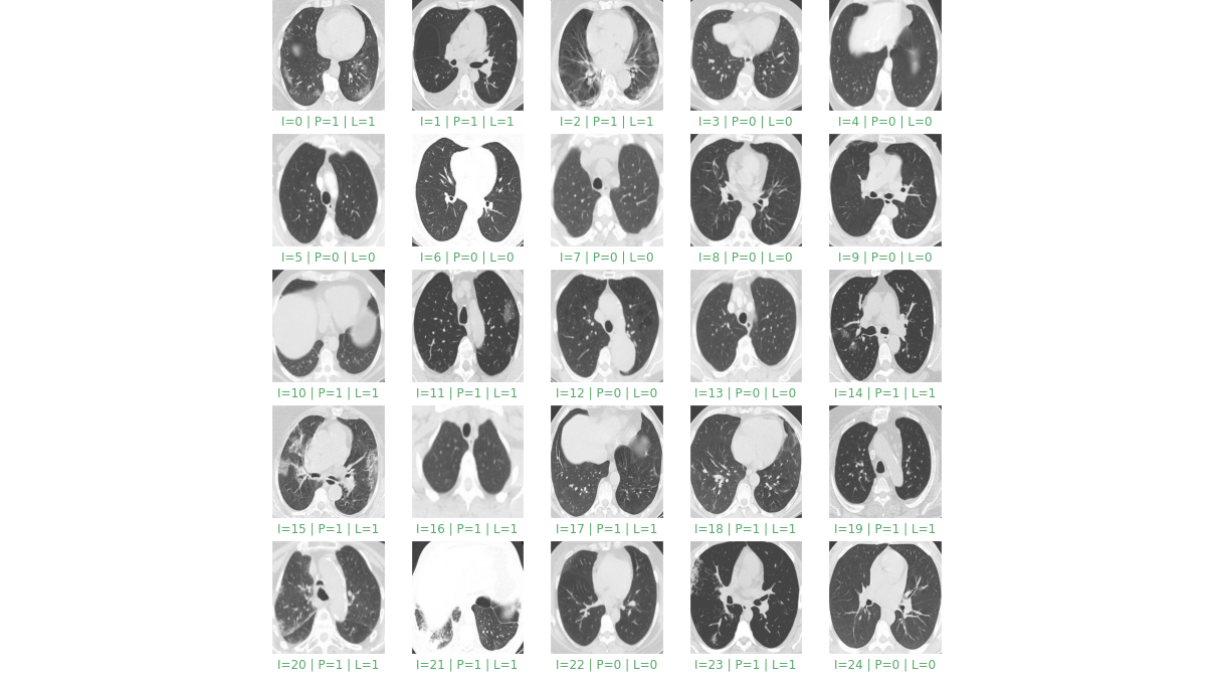
Figure 4. Results of the detection on the first 25 samples from the test set. “I” is the image index, “P” is the predicted value, and “L” is the grand truth label. Green indicates correct detection and red indicates incorrect